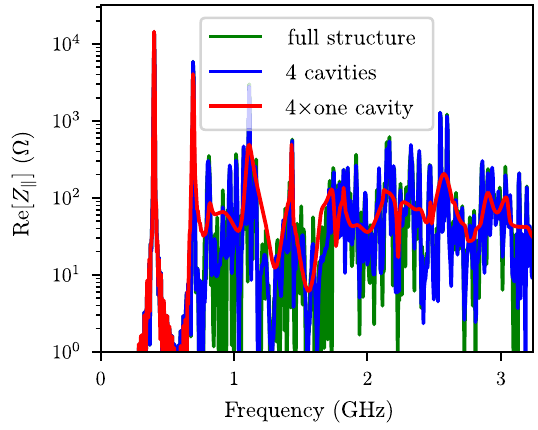
FIG. 11. Comparison of impedance of the full structure con- taining four single-cell cavities with and without tapers, and of the single-cell cavity multiplied by a factor of 4.